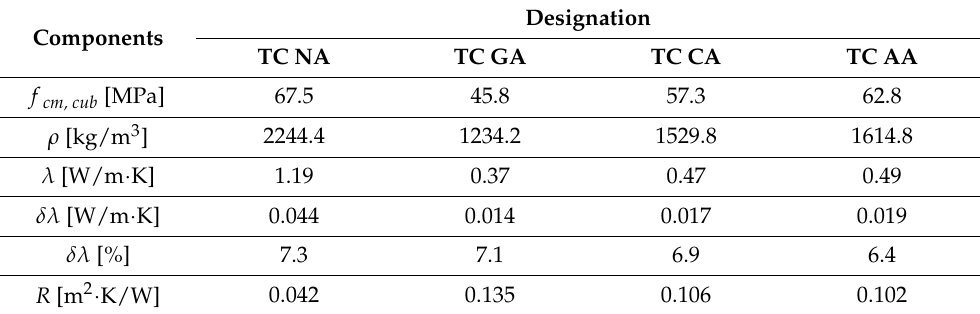
Table 6. The obtained measurement